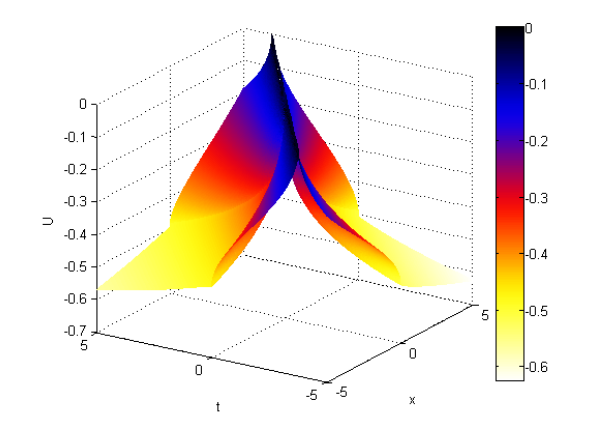
Fig. 3: The solution ˜ U 1 ( x , 0, 0, t ) in (4.15) for β =-2.6, γ =-3.5, δ =3, l =- 2,